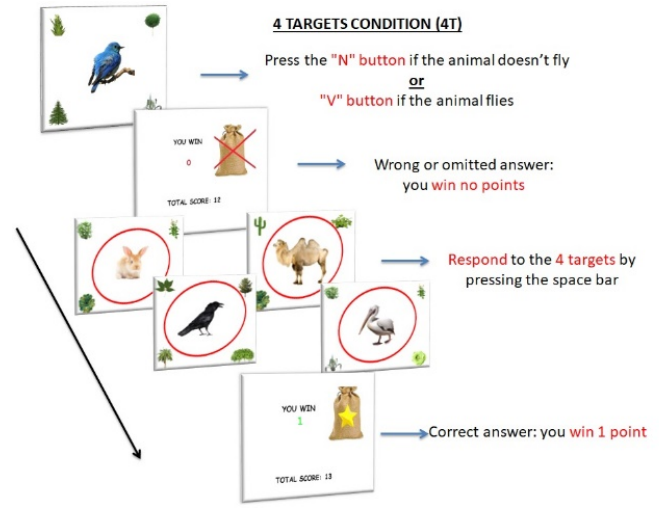
Figure 2. Procedure of 1 Target condition (1T). The items consisted of 120 images of an animal located at the center of the screen; images of plants were located at the four corners of the screen. As in the BC, participants had to press the “N” button when the image of a non-flying animal appeared on the screen and the “V” button when the image of a flying animal appeared on the screen (ongoing task). However, when a dove—PM target—appeared on the center of the screen (12 trials), participants were required to press the spacebar (PM task), instead of the semantic decision task. Each stimulus appeared for 2 s. They received 1 RP for every correct answer and no RP for any wrong or omitted answer, in both tasks (ongoing and PM trials).